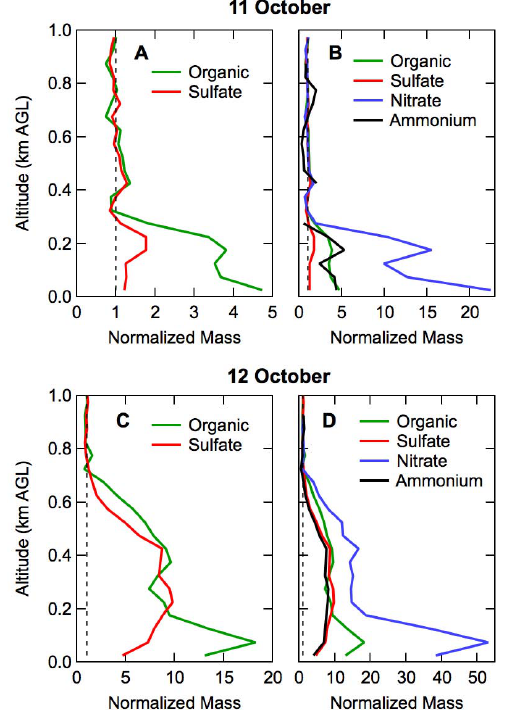
Fig. 16. Normalized mass loading of aerosol organic, sulfate, ni- trate and ammonium from the average of 5 vertical profiles between midnight and 01:00 LT on 11 October (A, B) and 12 October (C, D) . Panels (B) and (D) show the same data for organics and sulfate as do (A) and (C) , respectively, but on a scale that is also appro- priate for nitrate and ammonium. Mass loadings are averaged into 50m bins and normalized to the value above the boundary layer (400–1000m on 11 October, 700–1000m on 12 October) to show relative enhancements as a function of decreasing height for each